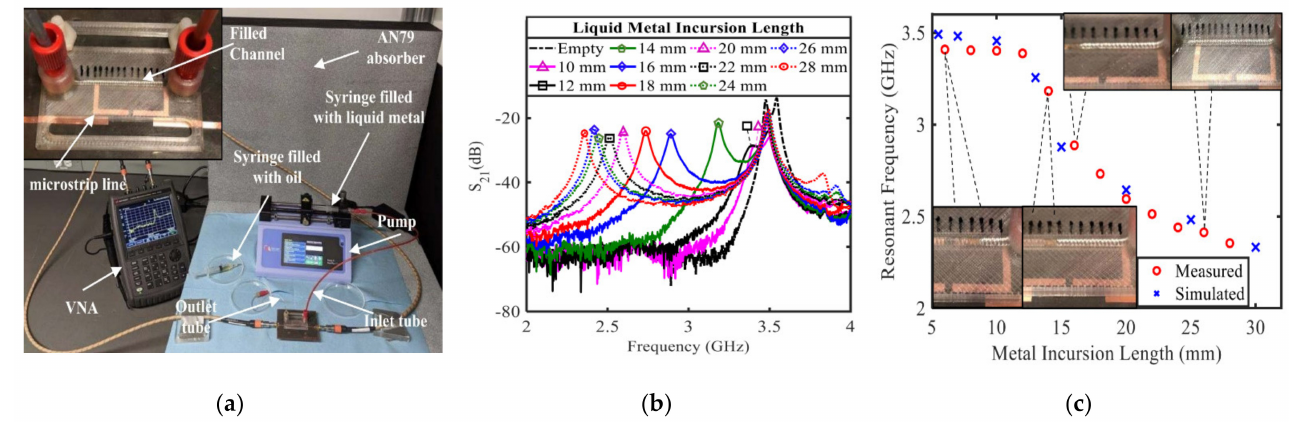
Figure 14. ( a ) Experimental device for measuring the S 21 result of resonator proposed. Fabricated resonator filled with Galinstan and microchannels are shown in the upper left corner of illustration. ( b ) Resonator S 21 spectra recorded by the VNA under different LM incursion length. ( c ) Record resonance frequencies of different metal lengths, including selected images. Reprinted with permission from Ref. [13]. Copyright 2020